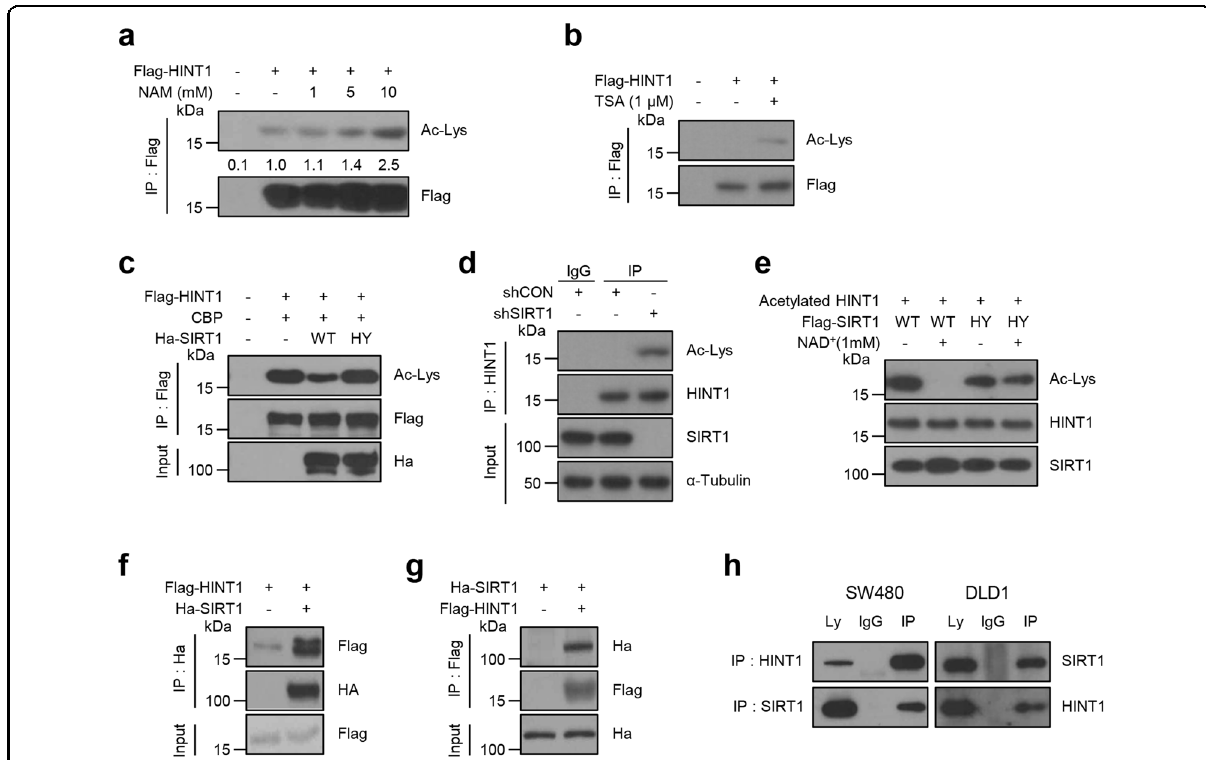
Fig. 2 HINT1 binds to and is deacetylated by SIRT1. a , b Flag-HINT1 was overexpressed in HEK293T cells, and then the cells were treated with a NAM for 24 h or b TSA for 6 h at different concentrations as indicated. c Flag-HINT1 was coexpressed with CBP, wild-type SIRT1 (WT), or SIRT1- catalytic mutant (H363Y) in HEK293T cells. a – c The acetylation levels of Flag-bead-IPed HINT1 were determined by western blot analysis. d SIRT1 was knocked down by a lentiviral system (shSIRT1) in DLD1 cells. Acetylation levels of HINT1 IPed with its antibody were determined by western blot assay. e For the in vitro deacetylation assay, 1 μ g of the acetylated HINT1 protein was incubated with recombinant SIRT1 WT or SIRT1 HY in the presence or absence of NAD + (1mM) at 37°C for 2 h, followed by western blot analysis. f , g For the reciprocal interaction between HINT1 and SIRT1, Flag-HINT1 was coexpressed with HA-SIRT1 in HEK293T cells. SIRT1 or HINT1 was immunoprecipitated with HA ( f ) or Flag ( g ) antibody, respectively, following western blot analysis using antibodies as indicated. h Endogenous HINT1 or SIRT1 proteins in SW480 or DLD1 cells were immunoprecipitated and immunoblotted with antibodies as